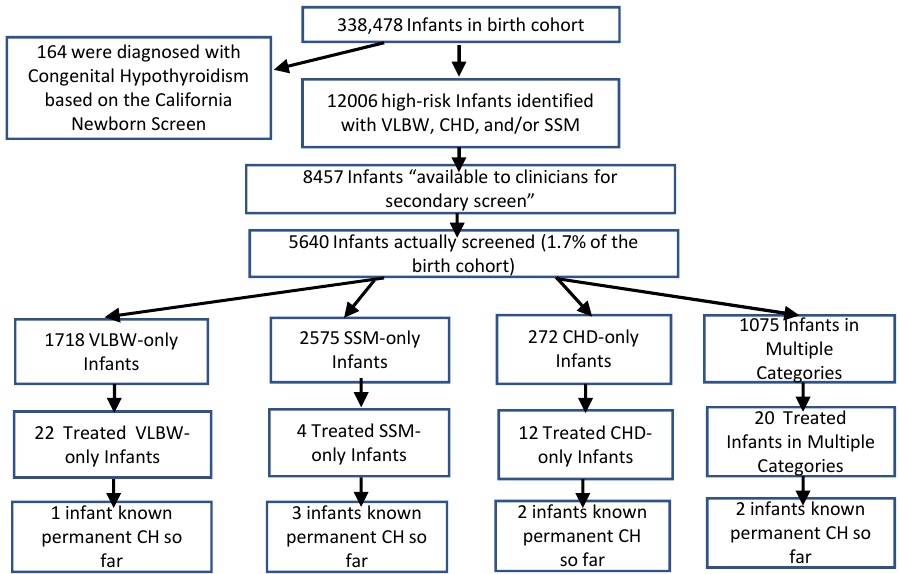
Figure 1. Overview of data collection and